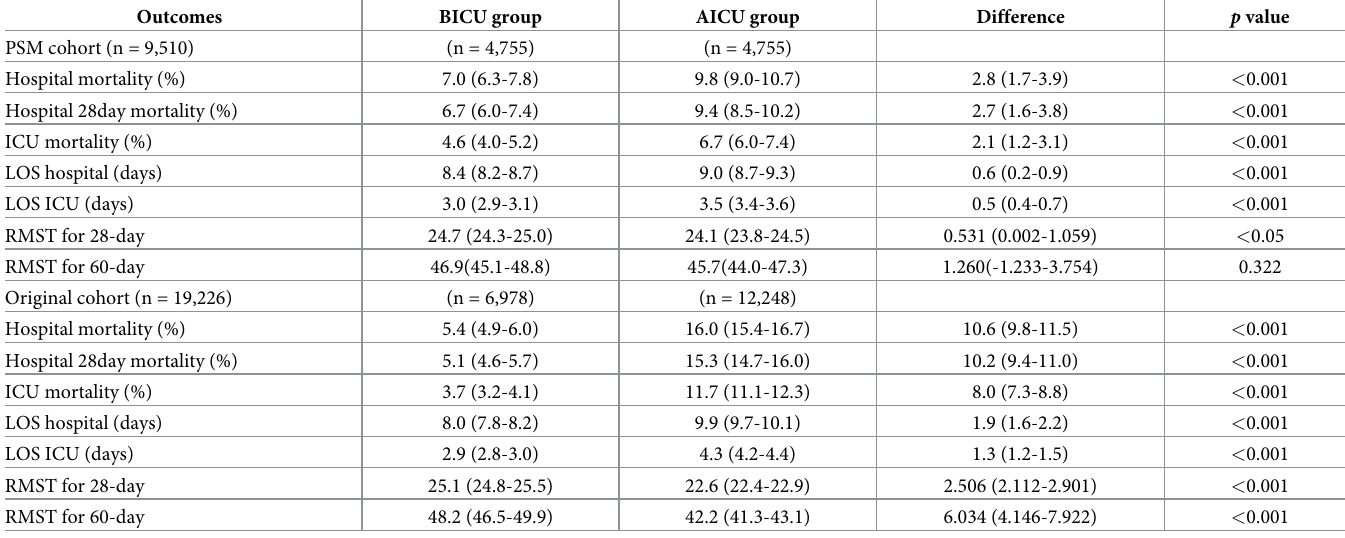
Table 2. Primary and secondary outcomes in original and PSM cohort.